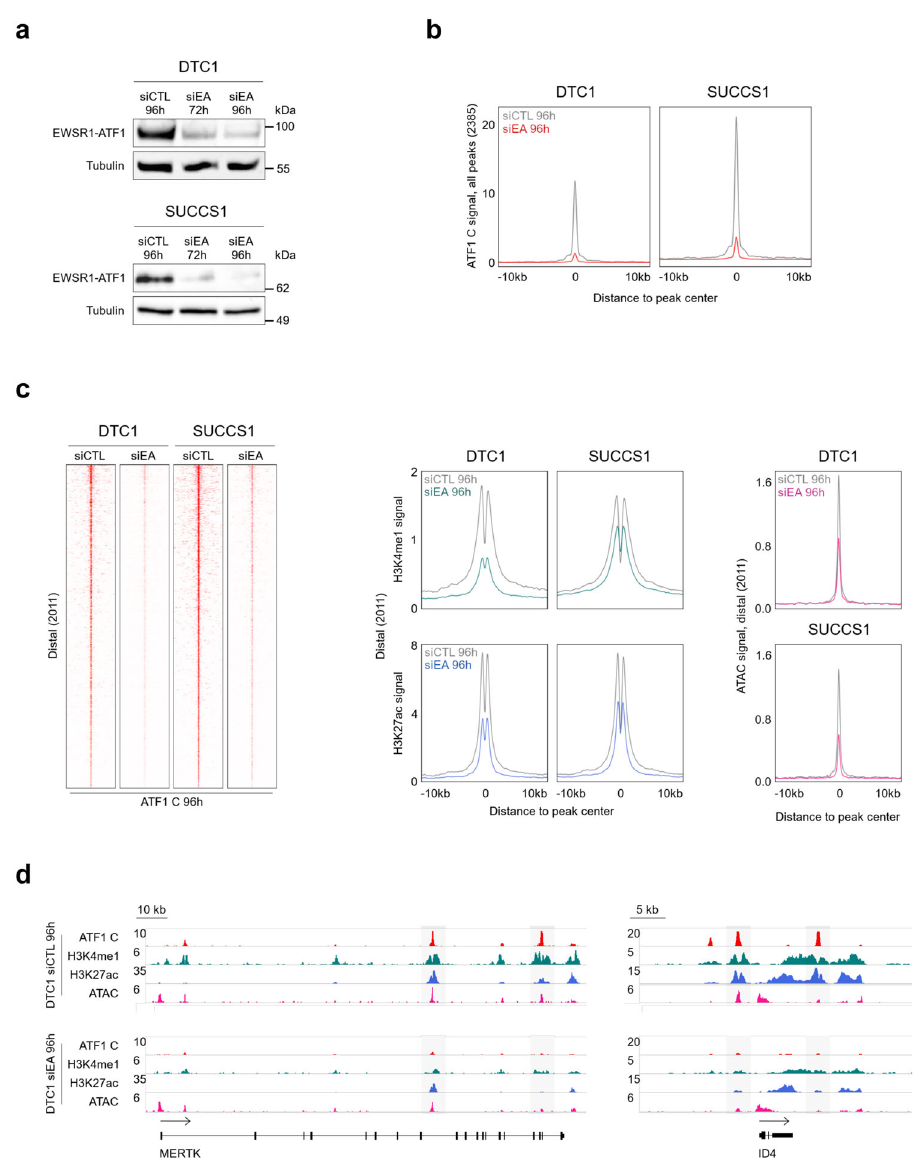
Fig. 2 EWSR1-ATF1 depletion reduces chromatin activation and DNA accessibility. a Western blot analysis of EWSR1-ATF1 protein levels in DTC1 and SU-CCS-1 cell lines transfected with a siRNA targeting the fusion gene (siEA 72 h and 96 h) or an unrelated sequence (siCTL 96 h). Tubulin protein levels were used as loading control. The experiment was independently repeated twice with similar results. Source images are provided in the Source Data fi le. b Composite plots showing the marked reduction in ATF1 C ChIP-seq signal at 2385 EWSR1-ATF1 bound sites in DTC1 and SU-CCS-1 cells transfected with either siEA or siCTL siRNAs for 96 h. c Left panel : Heatmaps depicting the distribution of ATF1 C ChIP-seq signal across 2011 EWSR1-ATF1 bound distal sites in siEA or siCTL-treated DTC1 and SU-CCS-1 cells at 96 h. Heatmaps show 20 kb genomic regions centered on EWSR1-ATF1 peaks ranked by ATF1 C signal intensity. Middle panel : composite plots of H3K4me1 ( upper panels ) and H3K27ac ( lower panel s) signal at 2011 EWSR1-ATF1 bound distal sites in siEA or siCTL-treated DTC1 and SU-CCS-1 cells at 96 h, showing a reduction in both enhancer marks upon EWSR1-ATF1 depletion. Right panel : composite plots of ATAC signal in siEA or siCTL-transfected DTC1 and SU-CCS-1 cells at 96 h, showing the reduction in chromatin accessibility associated with the loss of the fusion protein. d ChIP-seq and ATAC-seq tracks at the MERTK and ID4 genomic loci (as in Fig. 1e) in siEA or siCTL-treated DTC1 cells at 96 h, showing the decrease in chromatin activity and accessibility induced by the loss of EWSR1-ATF1. EWSR1-ATF1 binding regions are highlighted in